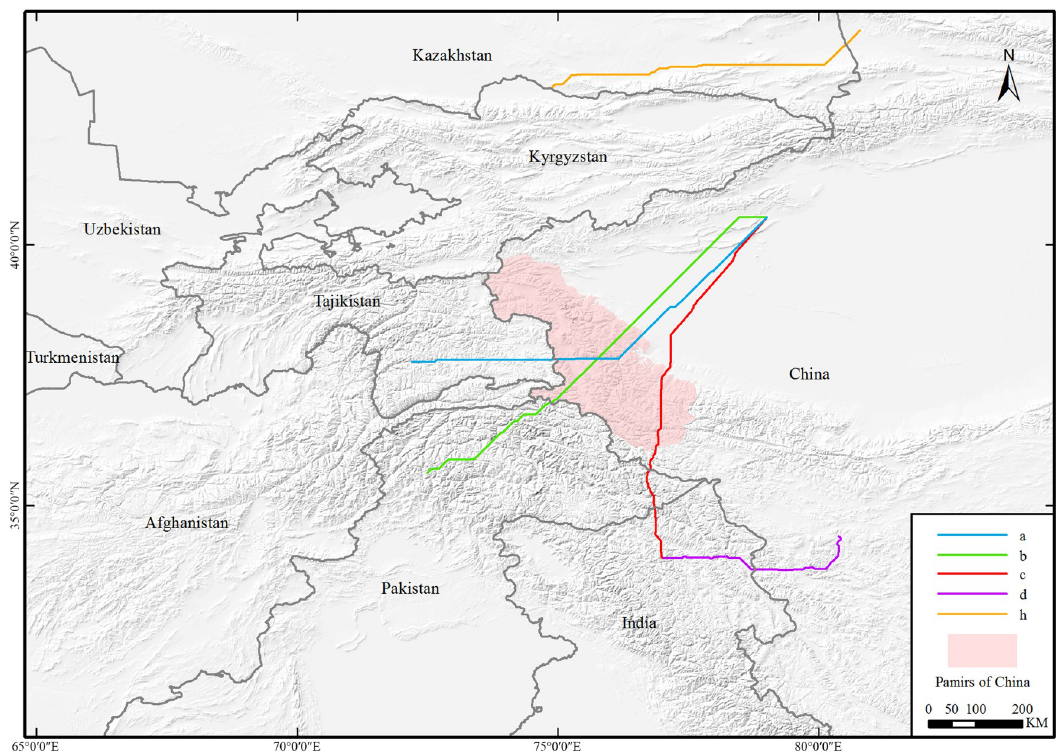
Fig 5. Transboundary LCPs for small ruminants. The boundary was obtained from Natural Earth (http://www.naturalearthdata. com/), which is a schematic line illustrating the relative position of each country and should not be re-used or misinterpreted for any political